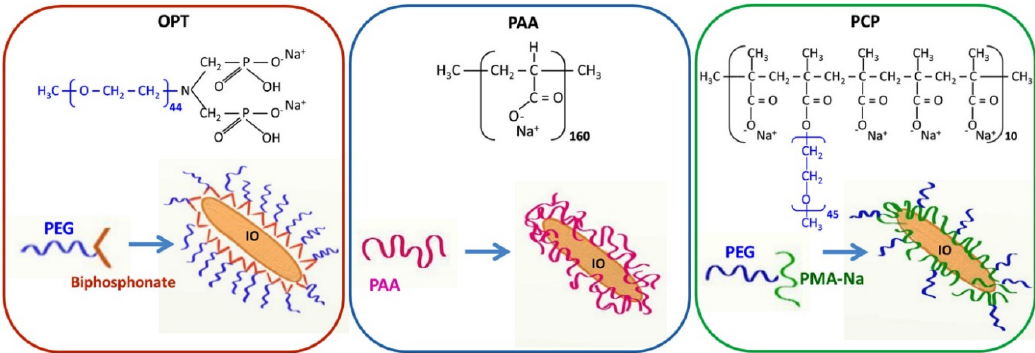
Figure 10. Schematic illustration of iron oxide nanorods coated with linear bisphosphonate −poly(ethylene glycol) (OPT), polyacrylic sodium salt (PAA), and polymethacrylate backbone/PEG side chain comb polymer (PCP). (Reprinted with permission from [97]. Copyright (2018), American Chemical Society). Poly(2-(methylsulfinyl) ethyl acrylate) (PMSEA), a highly hydrophilic sulfoxide polymer, was